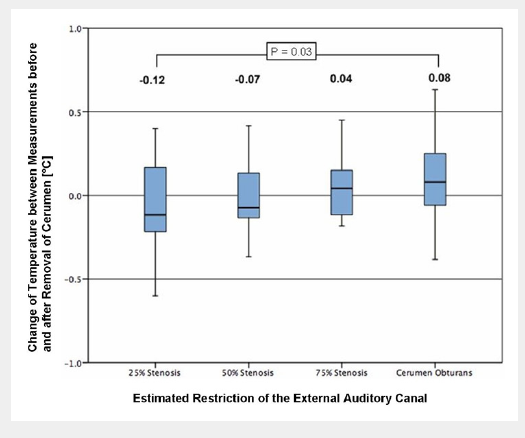
Infrared ear temperature measurements according to extent of cerumen. Box contains 50% of the median values, Whiskers define 95% CI.